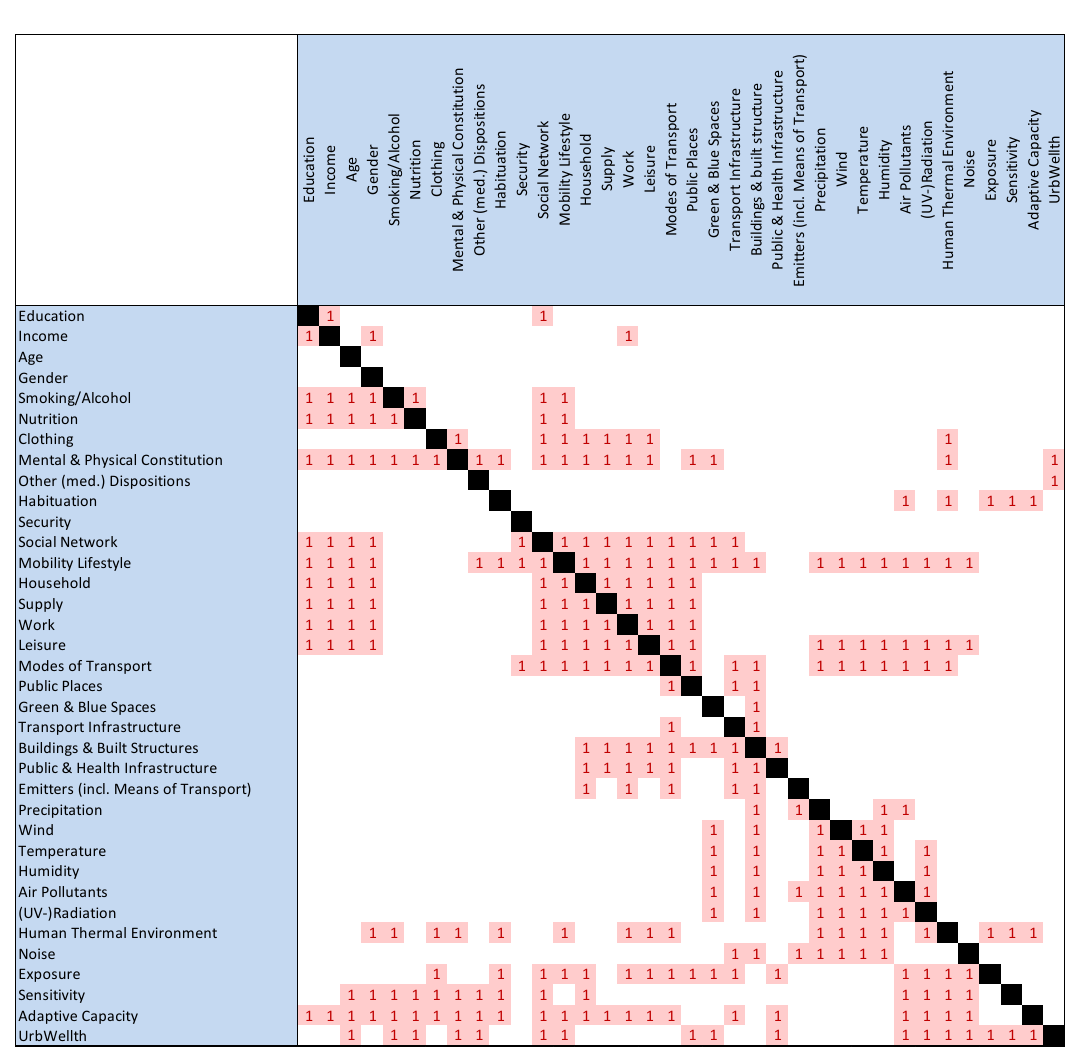
Figure 3. Design structure matrix based on the conceptual model of UrbWellth.